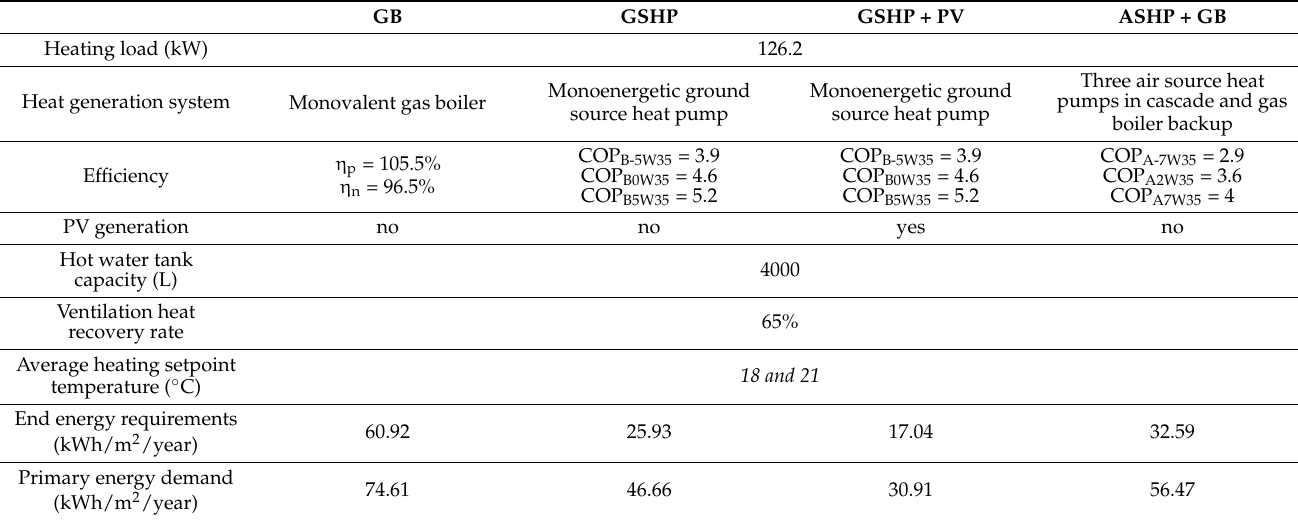
Table 2. Specifications of the heating systems and energy load.